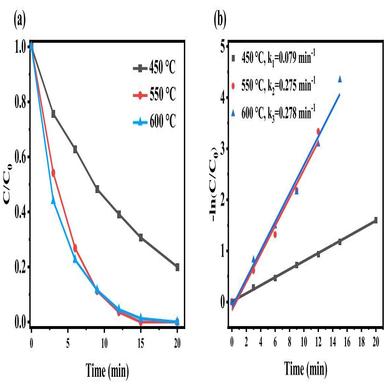
(a) Comparison of the performance of Cu3Ni/NC-600-one year nanocatalysts under different calcination temperatures, (b) Pseudo-first-order kinetics of the Cu3Ni/NC-T/PMS system. Experimental conditions: = 0.05 g/L, = 2.6 mM, = 12.5 mg/L, initial pH = 9, temperature = 25 ℃.